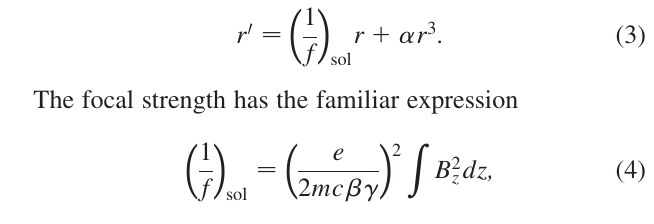
ffiffiffiffiffiffiffiffiffiffiffiffiffiffiffiffiffiffi p ffiffiffi p 8 200 = 147 ,